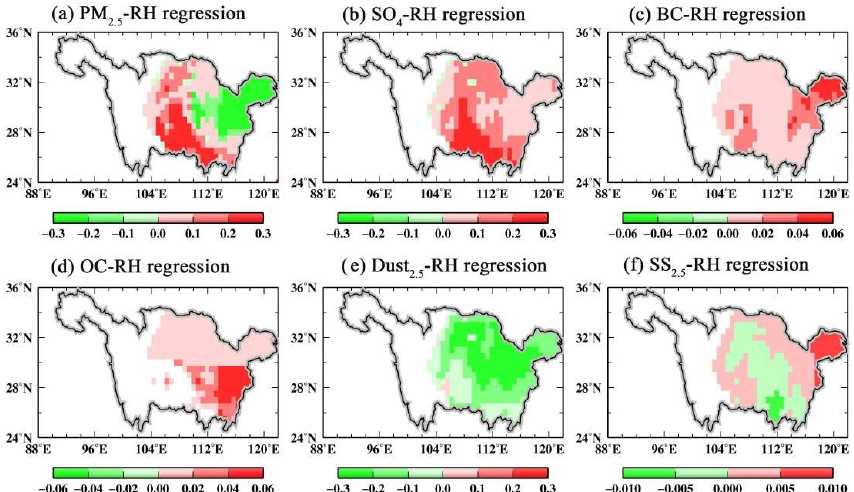
Figure 15. Multiple linear regression coefficients ( β 4 ) of each PM 2.5 component with relative humidity (RH), in units of µ g m − 3 % − 1 . The blank grids indicate invalid values. ( a – f ) refer to the regression coefficients of PM 2.5 , SO 4 , BC, OC, Dust 2.5 and SS 2.5 with relative humidity, respectively.